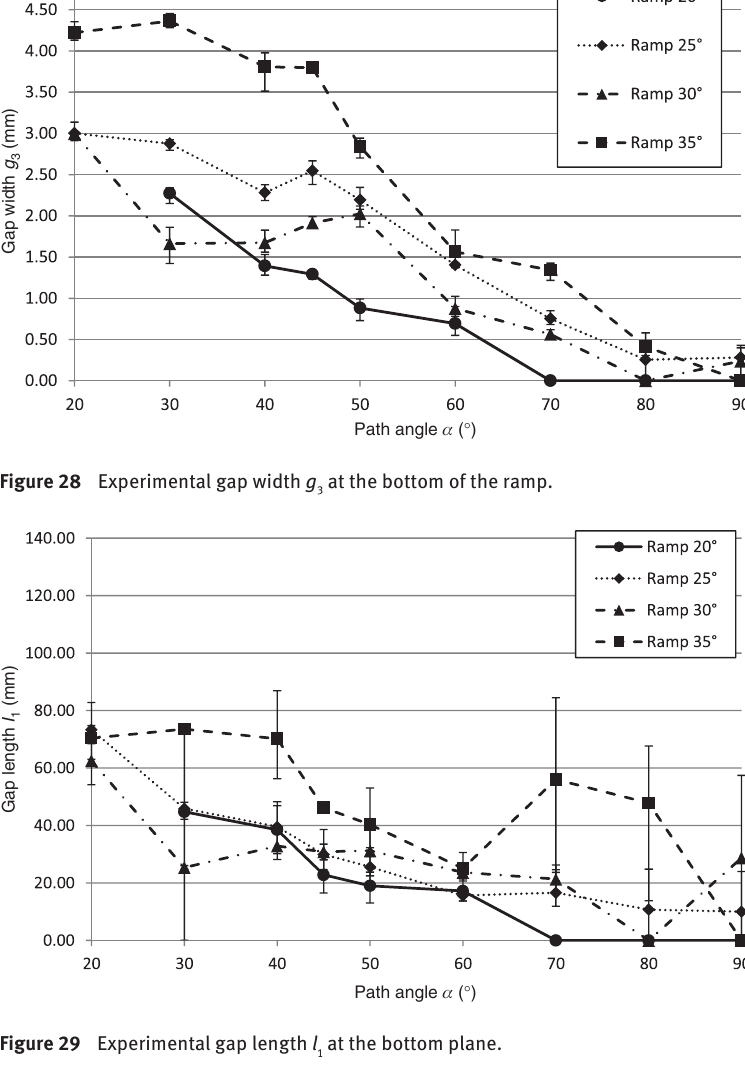
Figure 29 Experimental gap length l